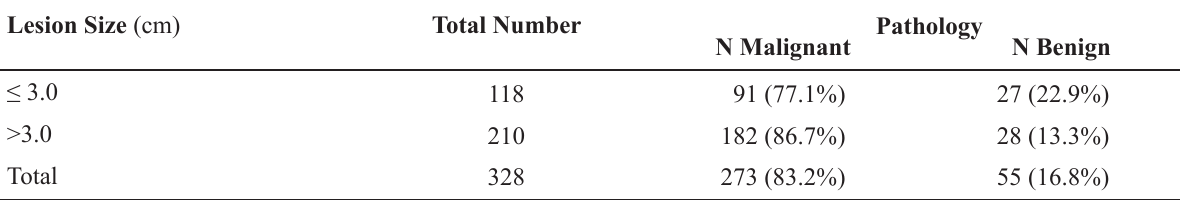
Table 2 – Surgical specimen lesion size and pathological findings.